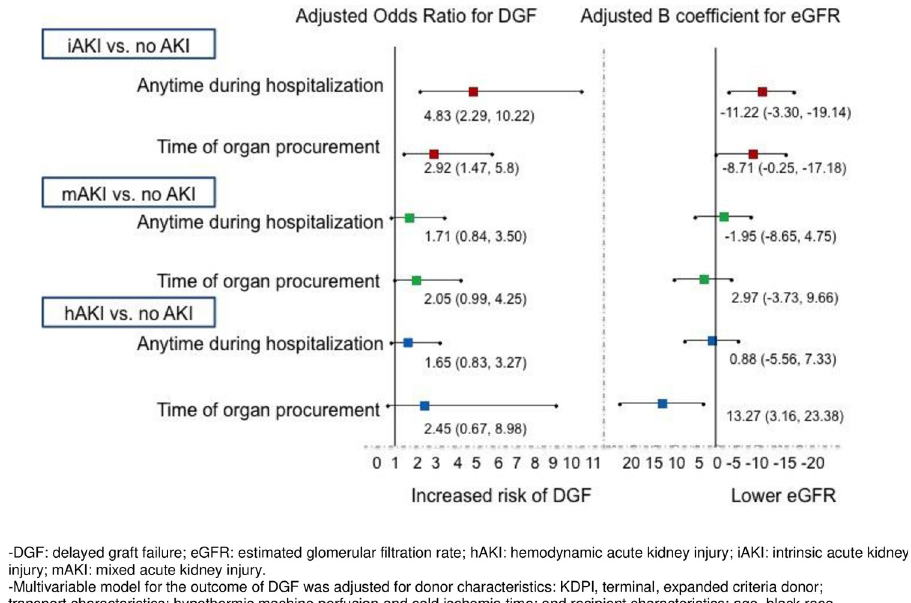
Fig 2. Associations of AKI phenotypes with DGF and 1-year eGFR. Shows the independent associations between AKI phenotypes as compared to hemodynamic AKI and the outcomes of delayed graft function and 1-year eGFR. The exposure of AKI phenotypes is shown both as defined by AKI happening anytime during donor hospitalization as well as AKI at time of organ